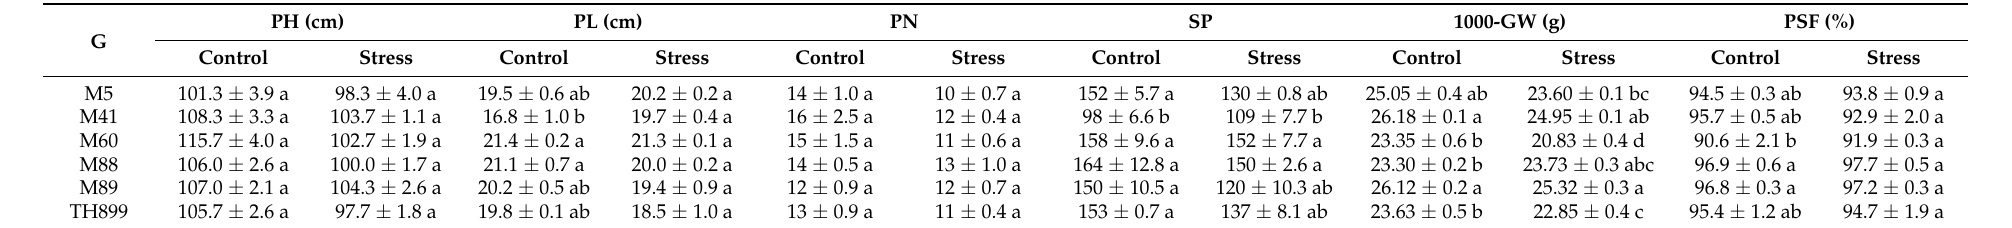
Table 4. Yield components of mutant lines under control and saline–alkaline stress conditions in 2019.